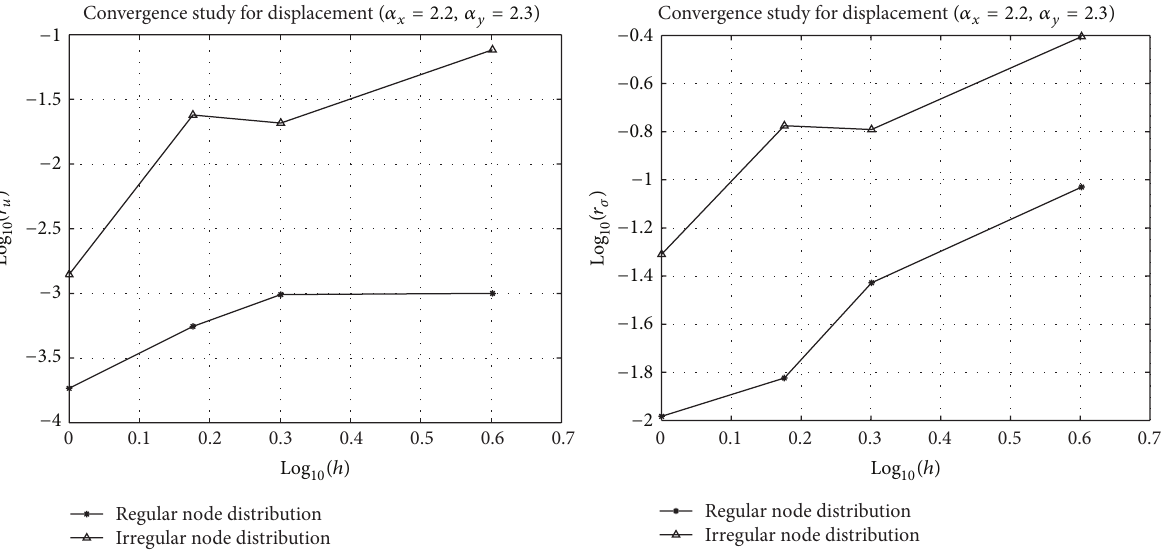
Figure 6: Convergence study for regular and irregular node